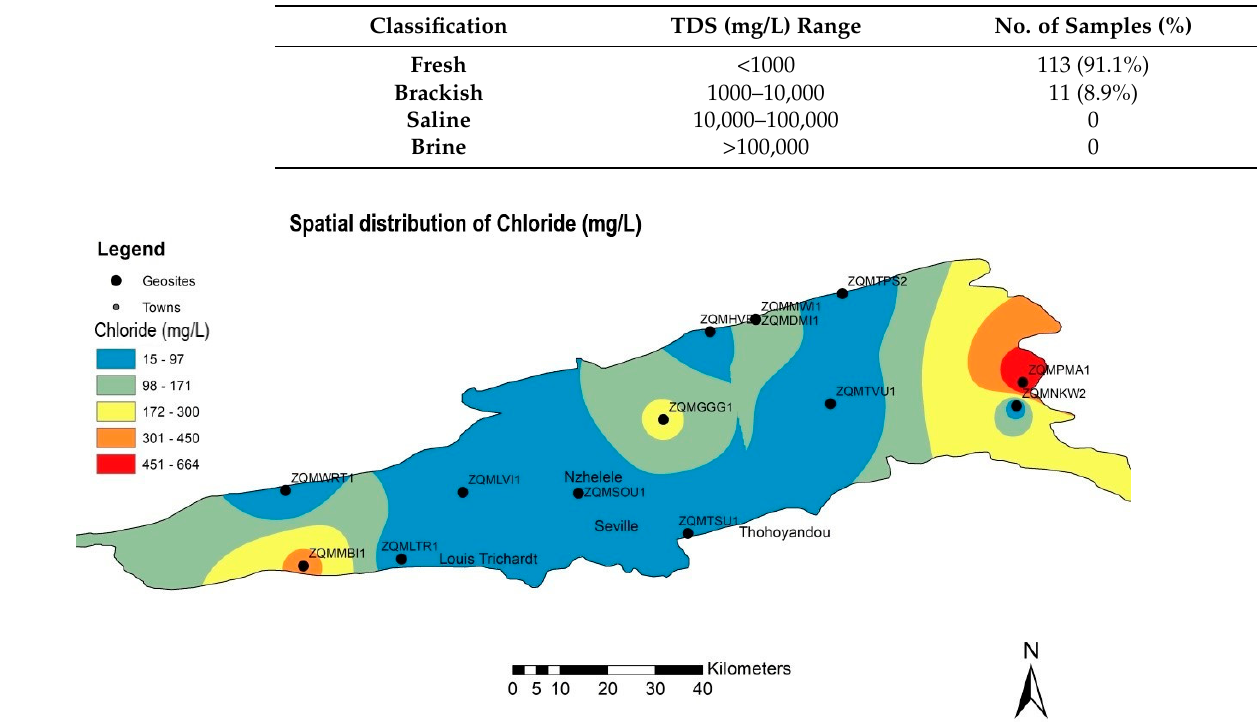
Figure 4. Spatial distribution of chloride in the Soutpansberg region.